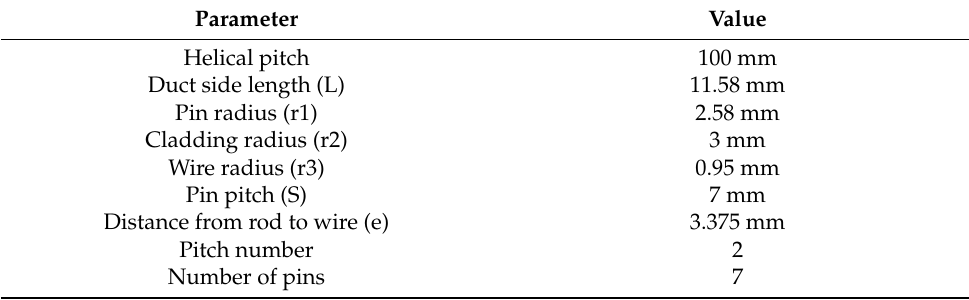
Figure 3. The planform of the flow region and fuel assembly. Table 1. Geometric parameters.